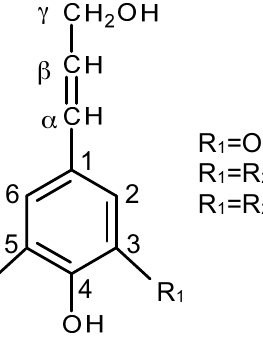
Figure 4. The three basic building blocks of lignin.